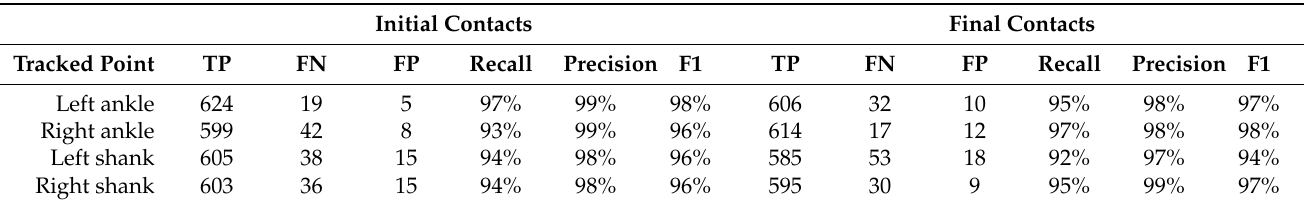
Table 5. Overall detection performance for initial contacts and final contacts as quantified by recall, precision, and F 1